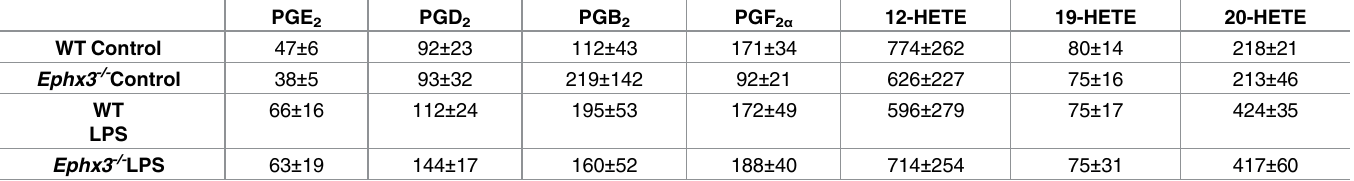
Table 2. Eicosanoids and Prostaglandins (pg/ml) in Plasma from Ephx3 -/- and WT mice treated with or without